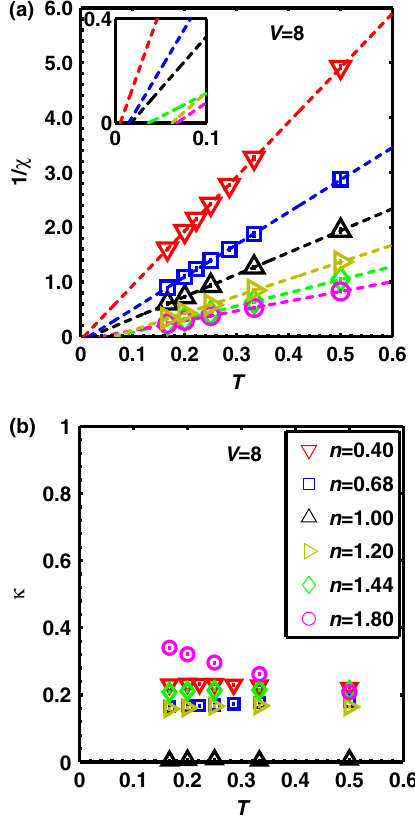
FIG. 2. (a) χ − 1 ð T Þ and (b) κ ð T Þ at a large value of V ¼ 8 in the temperature regime of 1 = 6 < T < 1 = 2 . Different values of n are shown in the legend in (b). At n ¼ 1 , the system is in the Mott- insulating state, and thus κ ð T Þ drops to nearly zero at low temperatures. The error bars of the QMC data are smaller than the